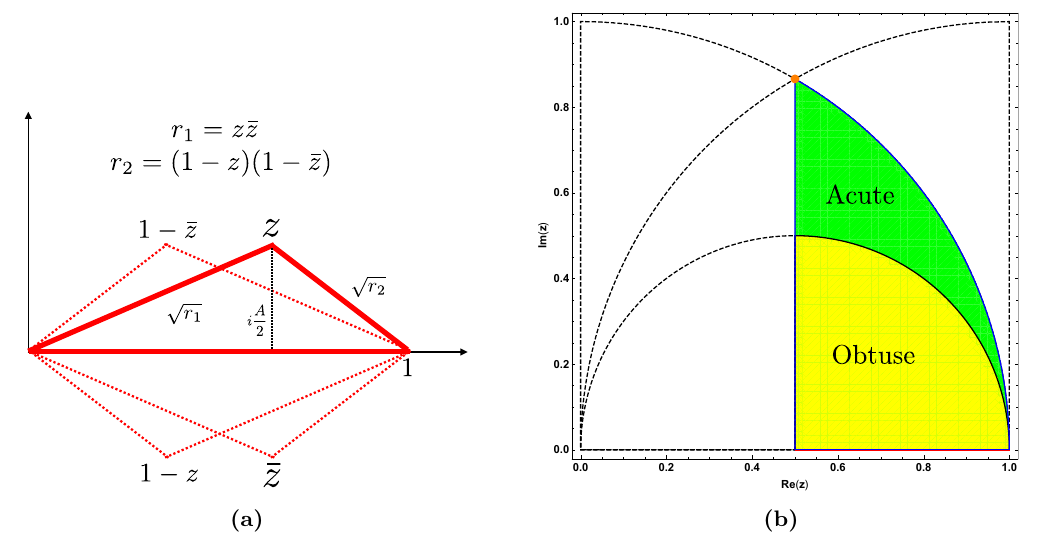
Figure 4. (a) Parametrization of unit triangle in terms of a complex variable z . (b) Enforcing that the unit side is the longest side, and removing triangles that are identical by parity, restricts the triangle to lie in the shaded region. Regions corresponding to obtuse and acute triangles are shown in yellow and green